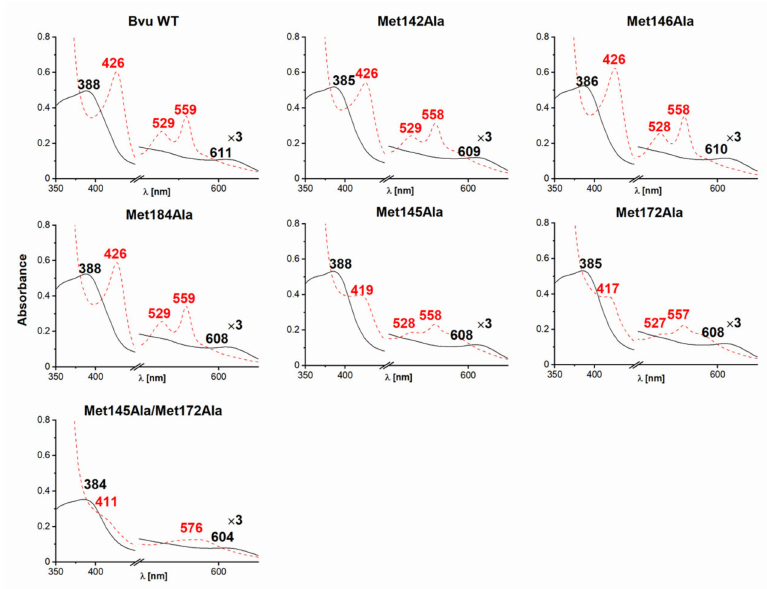
Figure 7. UV-visible absorption analysis of B. vulgatus Bvu site-directed mutagenesis variants com- plexed with heme. Spectra were recorded for the protein-Fe(III)heme complexes (solid, black line) and protein-Fe(II)heme complexes (dashed, red line). All spectra were recorded at a 1:1 protein:heme molar ratio for singly or dually replaced methionine residues by alanine residues. WT, wild-type protein. 2.4. B. vulgatus Bvu May Sequester Heme from Host Serum Albumin but Only